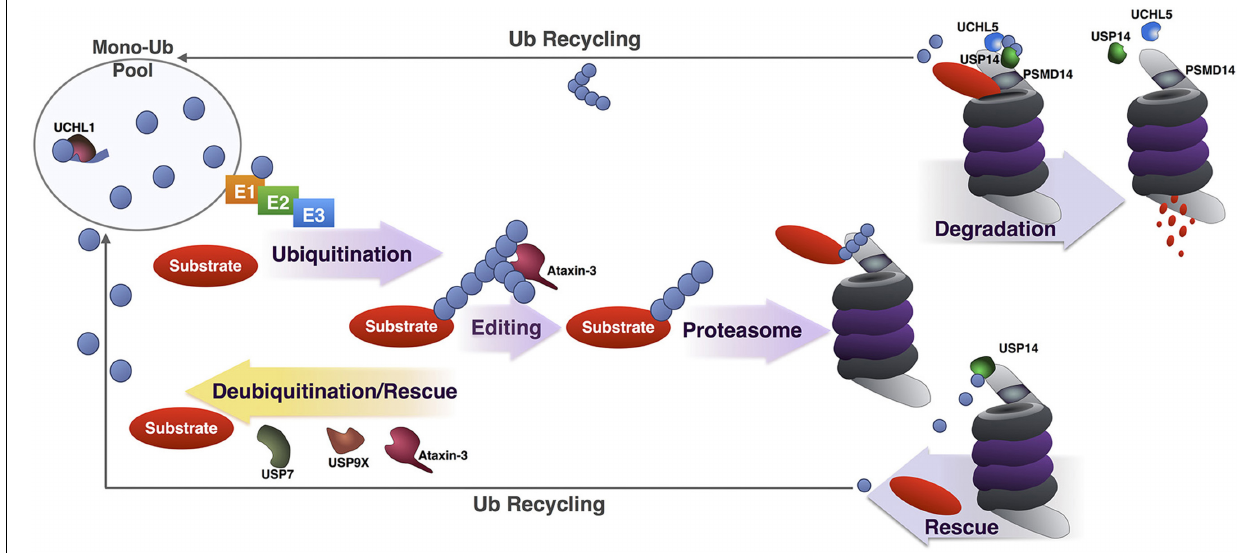
circumstances, ataxin-3 can deubiquitinate and rescue it from proteasomal degradation. Ataxin-3 has also been reported to enhance the degradation of a few substrates by editing poly-Ub chains for better recognition by and access to the proteasome. Once at the proteasome, premature deubiquitination of substrates by USP14 can prevent degradation. If a proteasome-bound substrate has been committed to degradation and is being unfolded, deubiquitination by PSMD14, UCHL5, and USP14 recycles